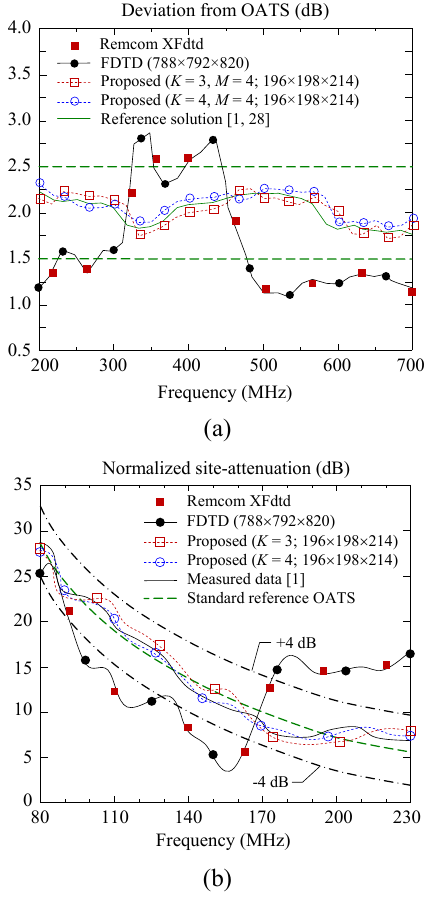
Figure 17: (a) Deviation from the OATS and (b) normalized site-attenuation for the inclined-wall compact ranger chamber. sions are: θ = 6.5 ο , l = 4.8 m, l = 3.5 m, l = 3.2 m, l = 3.4 A B C D m, l = 1.8 m, l = 3.6 m, and l = 2 m. The chamber is lined E F G with 20% carbon urethane pyramids and alternating wedges.